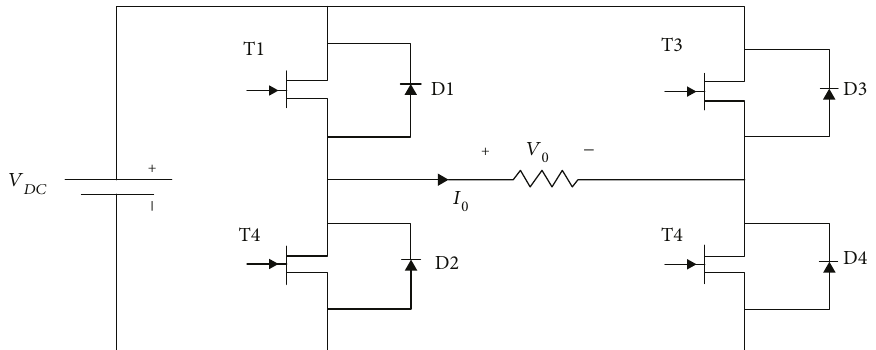
Figure 14: The full-bridge IGBT-based single-phase inverter.